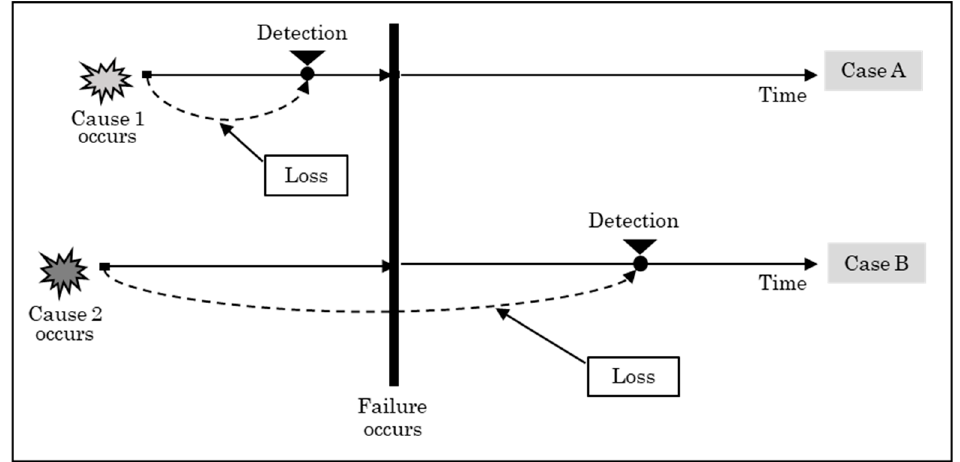
Figure 1. Effect of failure-cause detection time on the loss of a failure: If a detection is later than a failure, the loss increases rapidly.